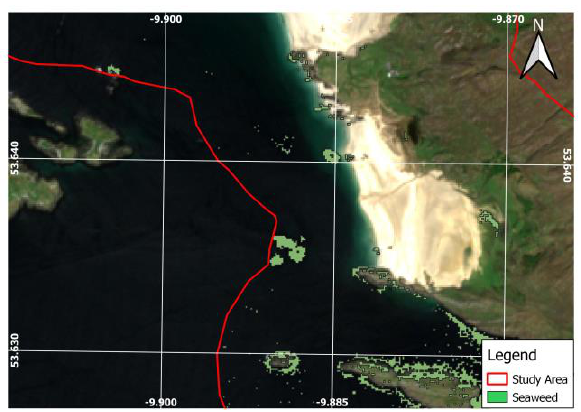
Figure 5 . Particular of Seaweed areas detected – Uggool beach.